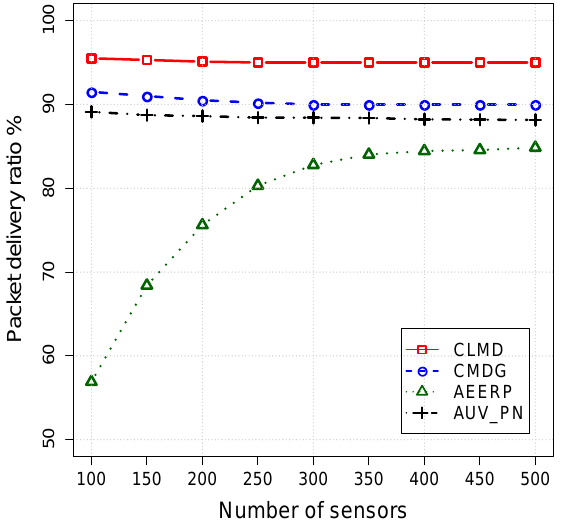
Figure 4. Packet delivery ratio vs. node